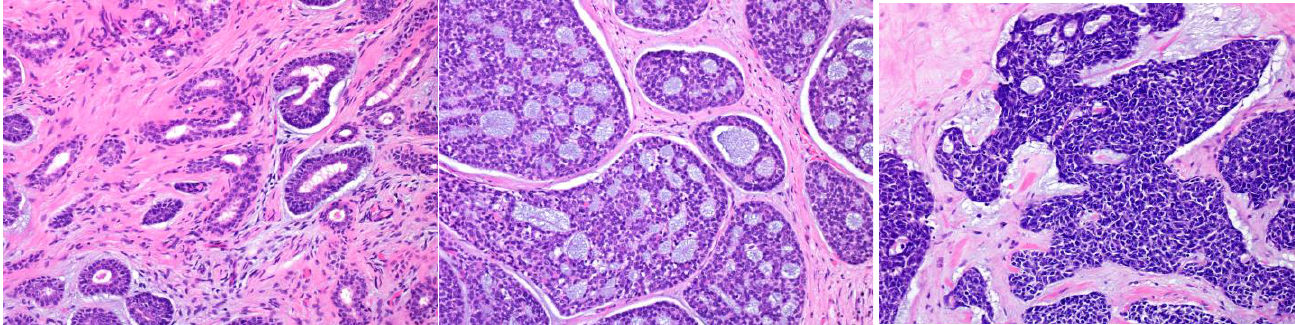
Figure 5. The histological grade of adenoid cystic carcinoma (AdCC). The tumor shows tubular ( left ), cribriform ( middle ), and solid ( right ) growth patterns.